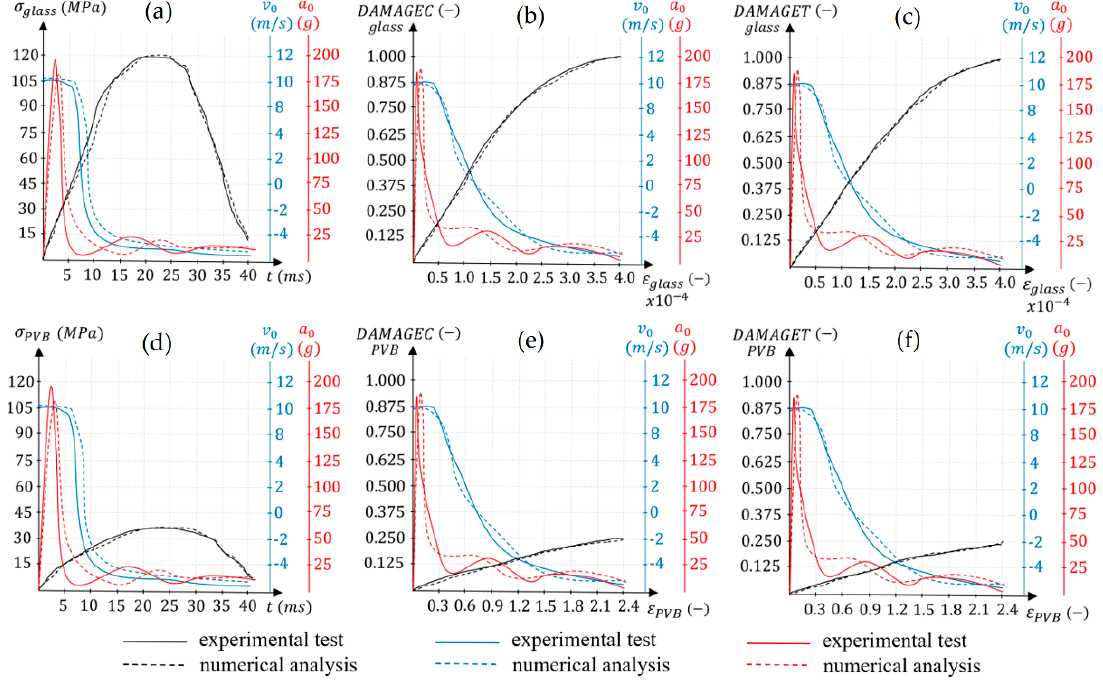
Figure 7. Comparison of results of experimental testing and numerical analyses based on the carried-out interpolation of result values for 20 attempts of destructive testing of samples during Test no. 1: ( a ) graph stresses σ glass in time t ; ( b ) graph DAMAGEC in strain ε glass ; ( c ) graph DAMAGET in strain ε glass ; ( d ) graph stresses σ PVB in time t ; ( e ) graph DAMAGEC in strain ε PVB ; ( f ) graph DAMAGET in strain ε PVB .